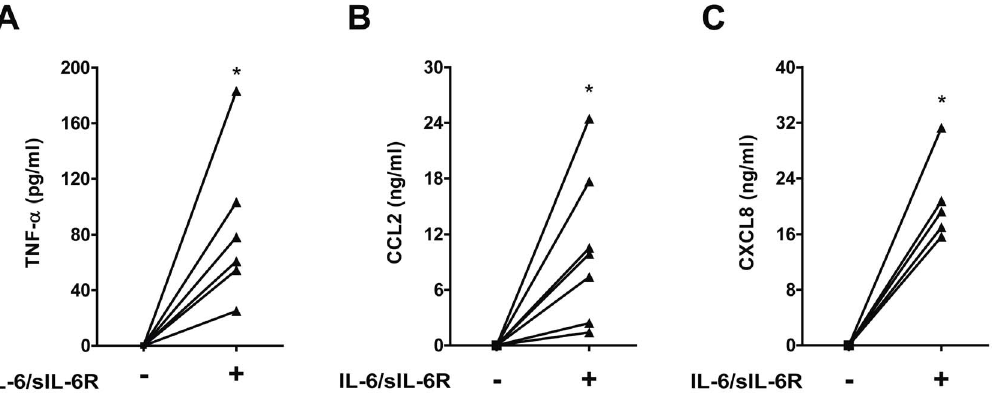
Figure 1. TNF- a , CCL2 and CXCL8 production in human PBMCs exposed to IL-6. Human PBMCs were exposed to IL-6 (10 ng/ml) in combination with sIL-6R (125 ng/ml) (IL-6/sIL-6R) for 18 hours. TNF- a , CCL2 and CXCL8 levels were measured by ELISA. *p , 0.05 for values from IL-6/ sIL-6R stimulated compared with not treated (NT) cells.